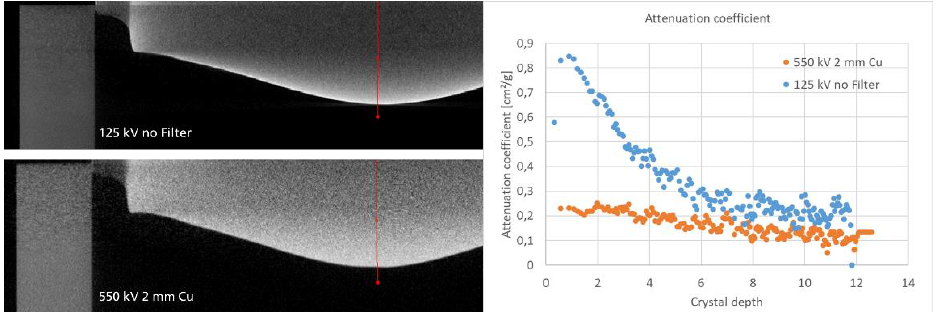
Figure 6. The influence of attenuation properties and X-ray energy on the density homogeneity in the reconstructed cross-section. The plot shows the two line profiles from bottom to top.